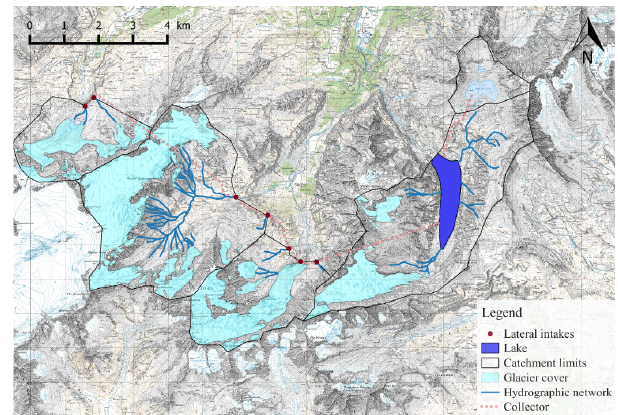
Figure 1. The main catchment of the Limmernboden dam with the additional catchment limited by lateral intakes and its glacier cover.